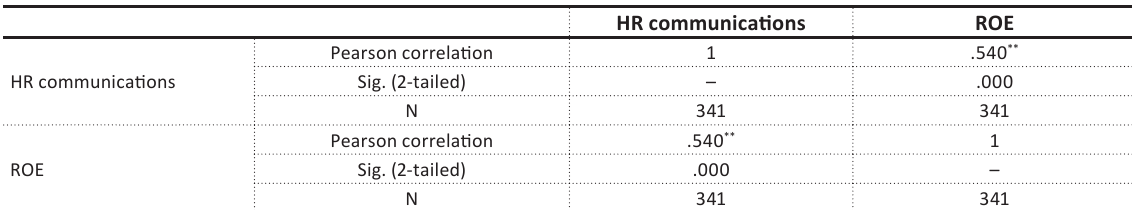
Table 4. Correlation analysis between HR communications and company’s return on equity